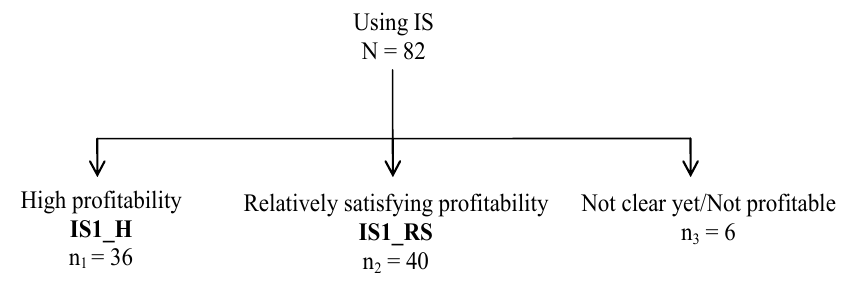
Figure 6. Profile of the respondents they have adopted IS with respect to the level of profitability. Table 4. Drivers for IS adoption—level of profitability.